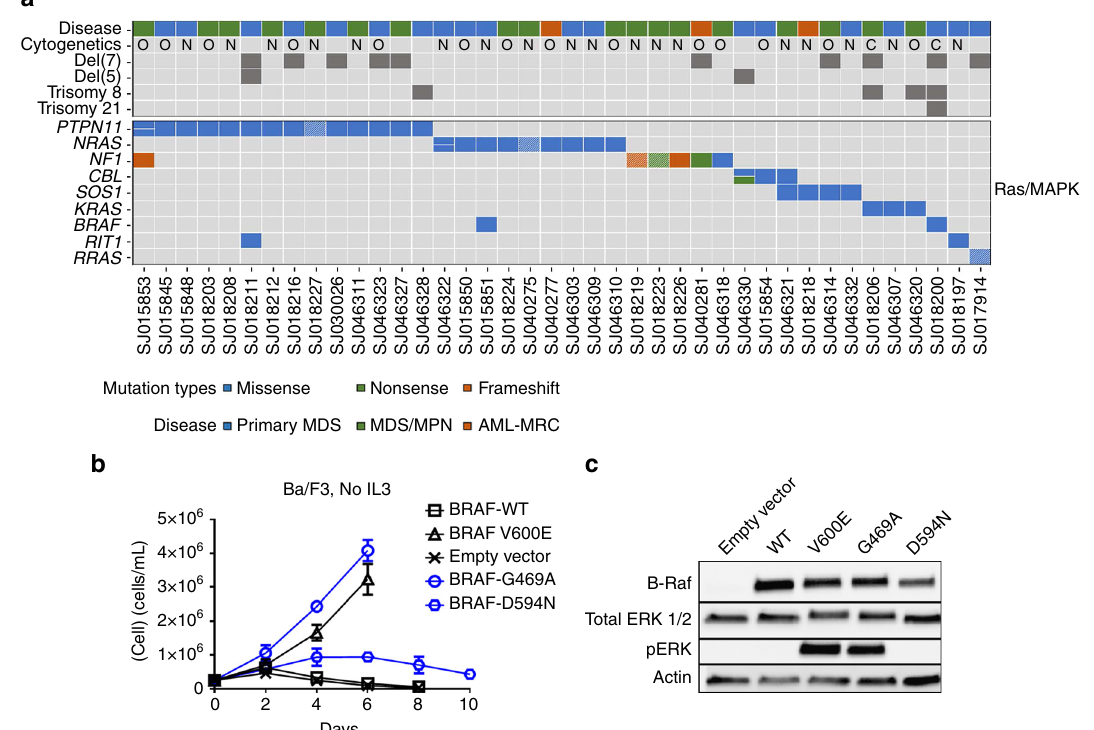
Fig. 5 Ras/MAPK pathway mutations in pediatric MDS, MDS/MPN, and AML-MRC. a Heat map showing all Ras/MAPK pathway mutations, both somatic and presumed germline (cells with hatched lines indicate presumed germline variants from WES tumor/normal cases), in the pediatric MDS cohort ( n = 77). b Growth curves of Ba/F3 cells transduced with retrovirus containing BRAF mutations. Blue curves indicate mutations found in the pediatric MDS cohort, and black curves are positive (V600E) and negative controls. Error bars indicate standard deviation. c Western blots of BRAF, total ERK, and phosphorylated ERK from lysates of 293 T cells transiently transfected with each BRAF mutation. Data are representative of three biological replicates